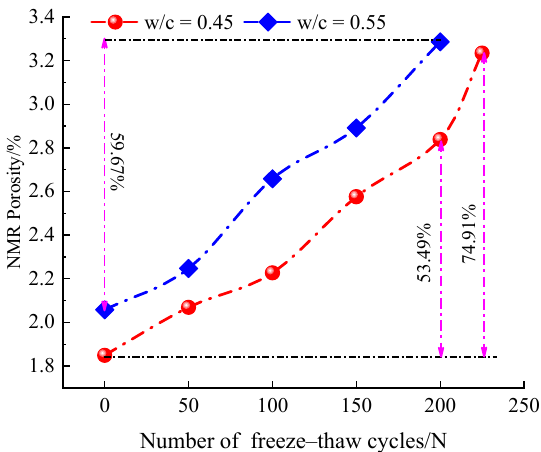
Figure 18. NMR porosity of concrete samples after different freeze–thaw cycles.